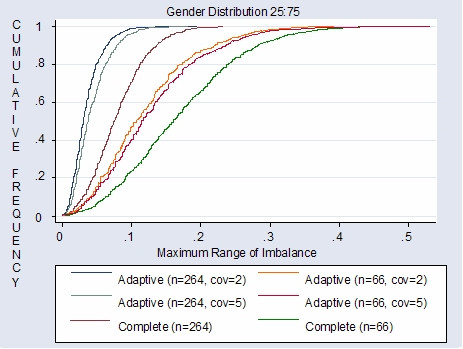
Complete and adaptive randomization: gender covariate imbalance (treatments = 3 simulations = 1000).